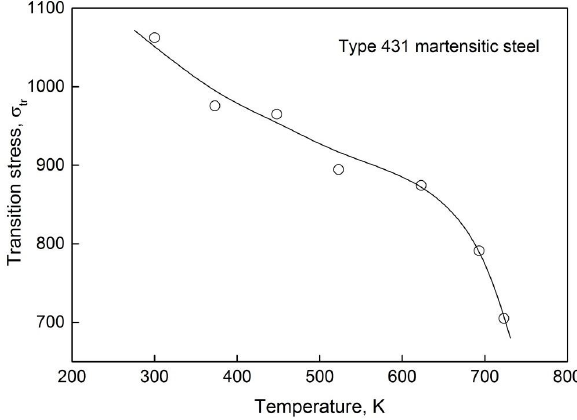
Figure 18: Variation of Ludwigson transition stress σ tr with tempera- ture for the AISI 431